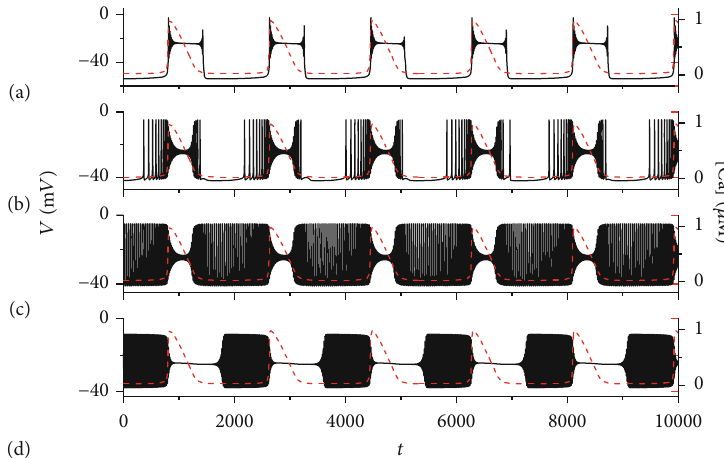
Figure 8: Firing pattern changes for di ff erent parameter values of k M Ω − 1 · V − 2 · s − 2 . The black solid and red dashed curves represent the time course of membrane potential V and intracellular calcium concentration [Ca], respectively. (a) k